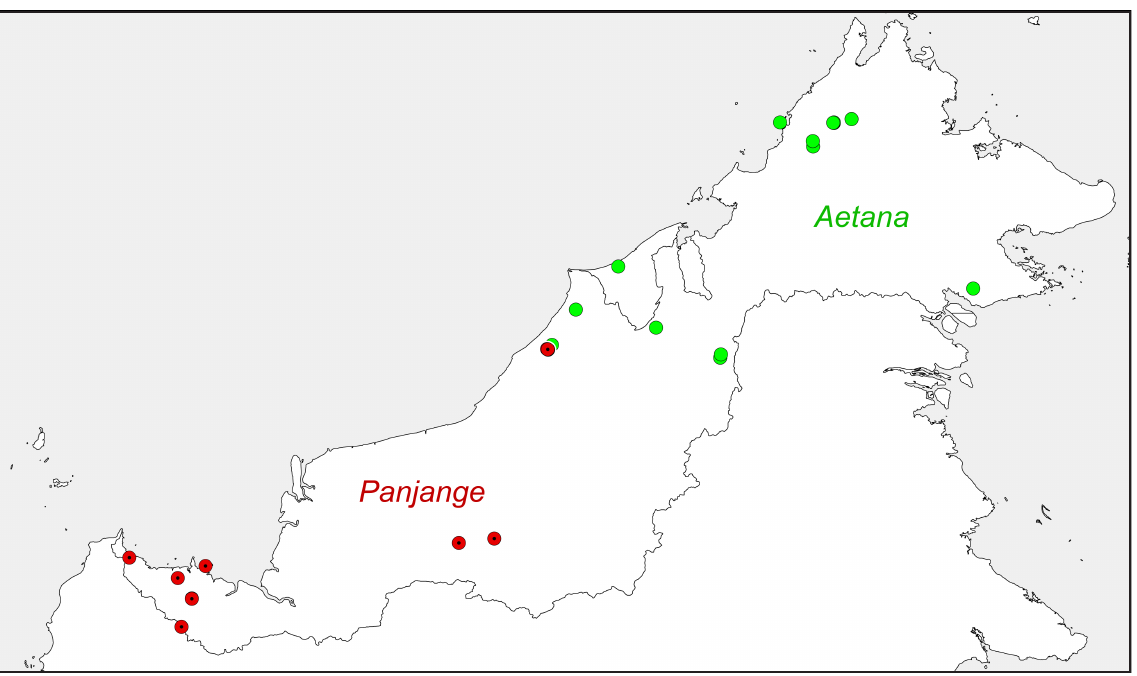
Fig. 95. Known distributions of the genera Panjange Deeleman-Reinhold & Deeleman, 1983 and Aetana Huber, 2005 in northern Borneo, showing the distinctness of western and eastern regions (distribution of Aetana from Huber et al.